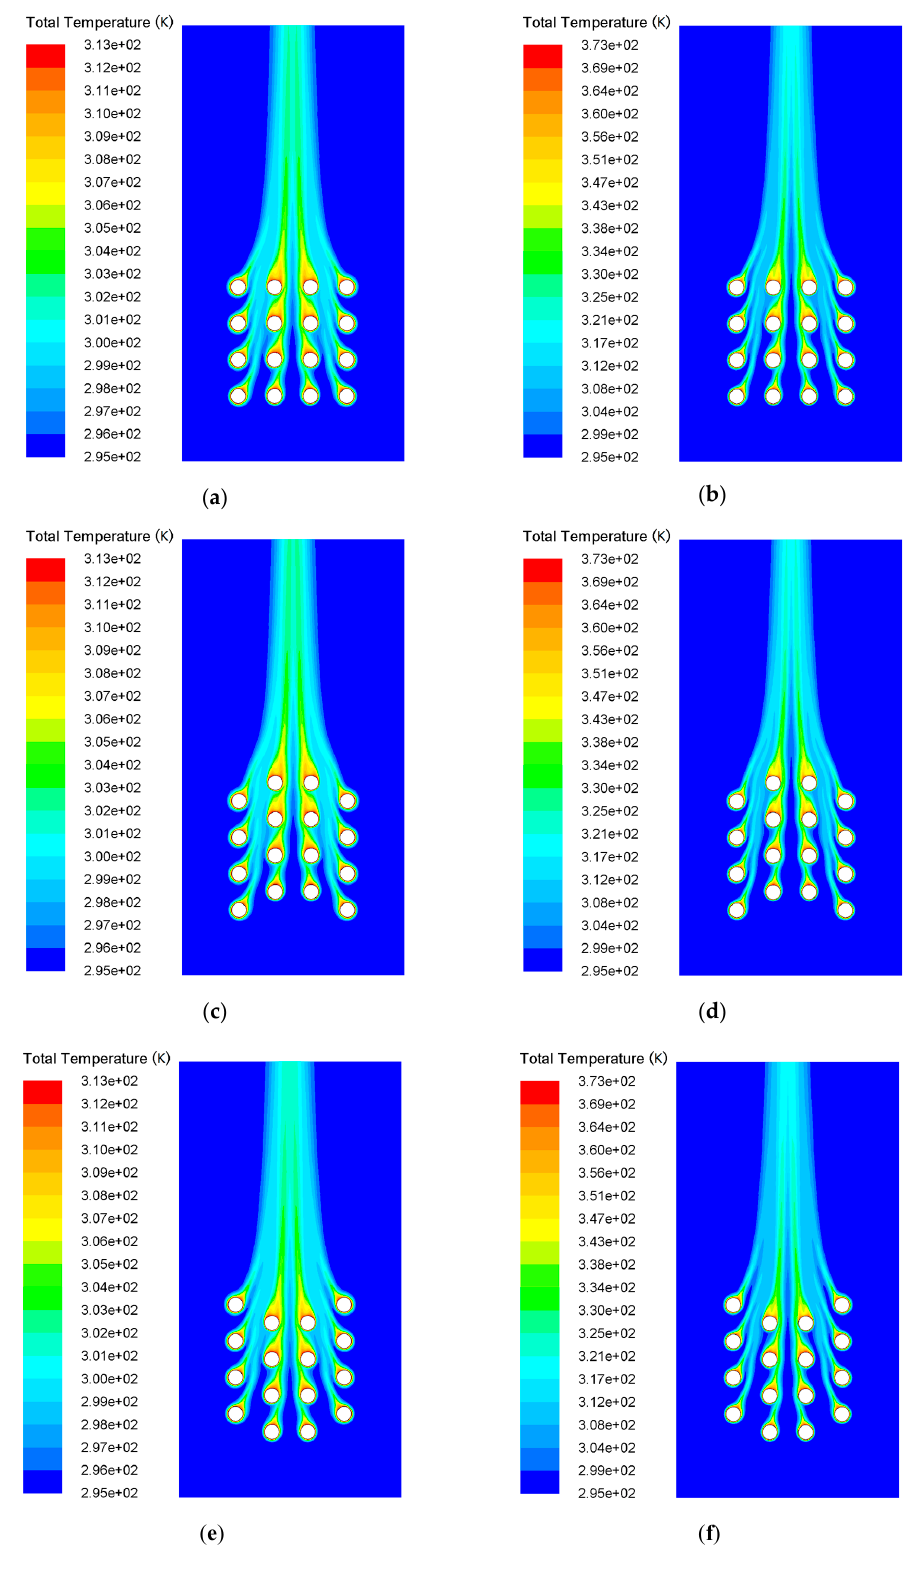
Figure 15. The temperature fields of the tube arrays 4 × 4 with the tube ratio spacing S/D = 2.5: ( a ) base configuration at Ra = 1.3 × 10 4 ; ( b ) base configuration at Ra = 3.7 × 10 4 ; ( c ) concave configuration at Ra = 1.3 × 10 4 ; ( d ) concave configuration at Ra = 3.7 × 10 4 ; ( e ) convex configuration at Ra = 1.3 × 10 4 ; ( f ) convex configuration at Ra = 3.7 × 10 4 .